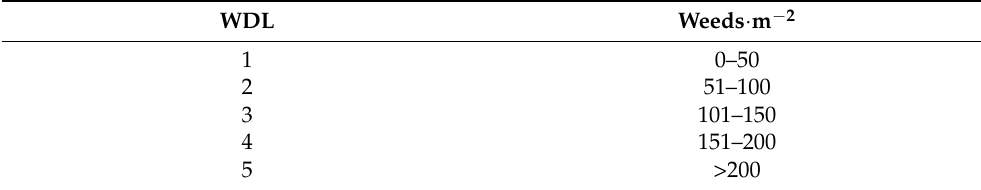
Table 5. Classification of the five different Weed Density Levels.